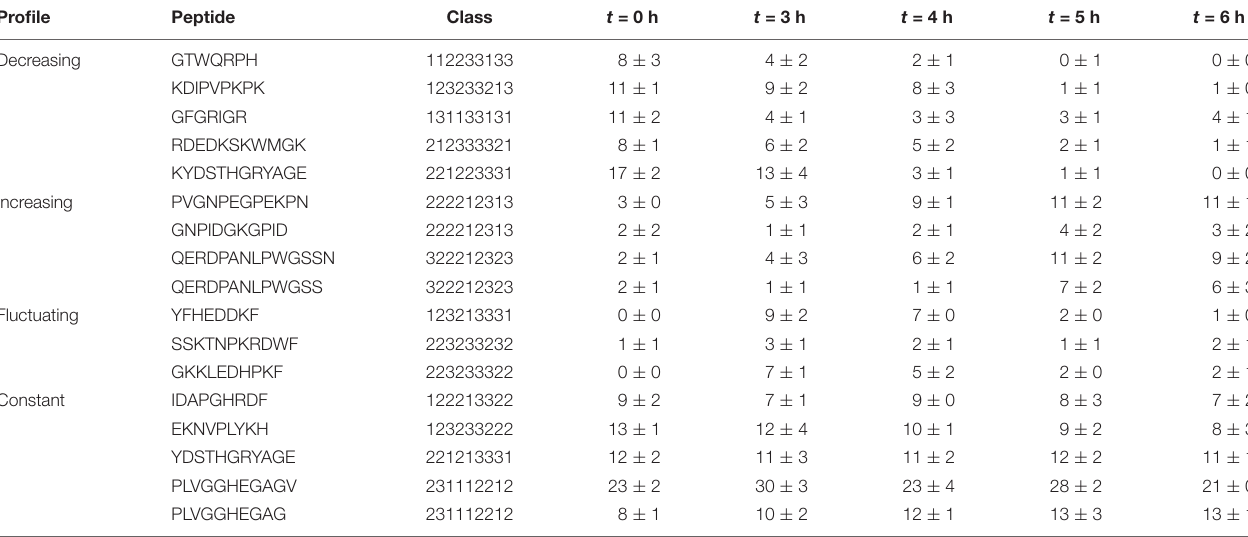
TABLE 5 | Spectral abundance of the most abundant peptides enclosed within the kinetic profiles.